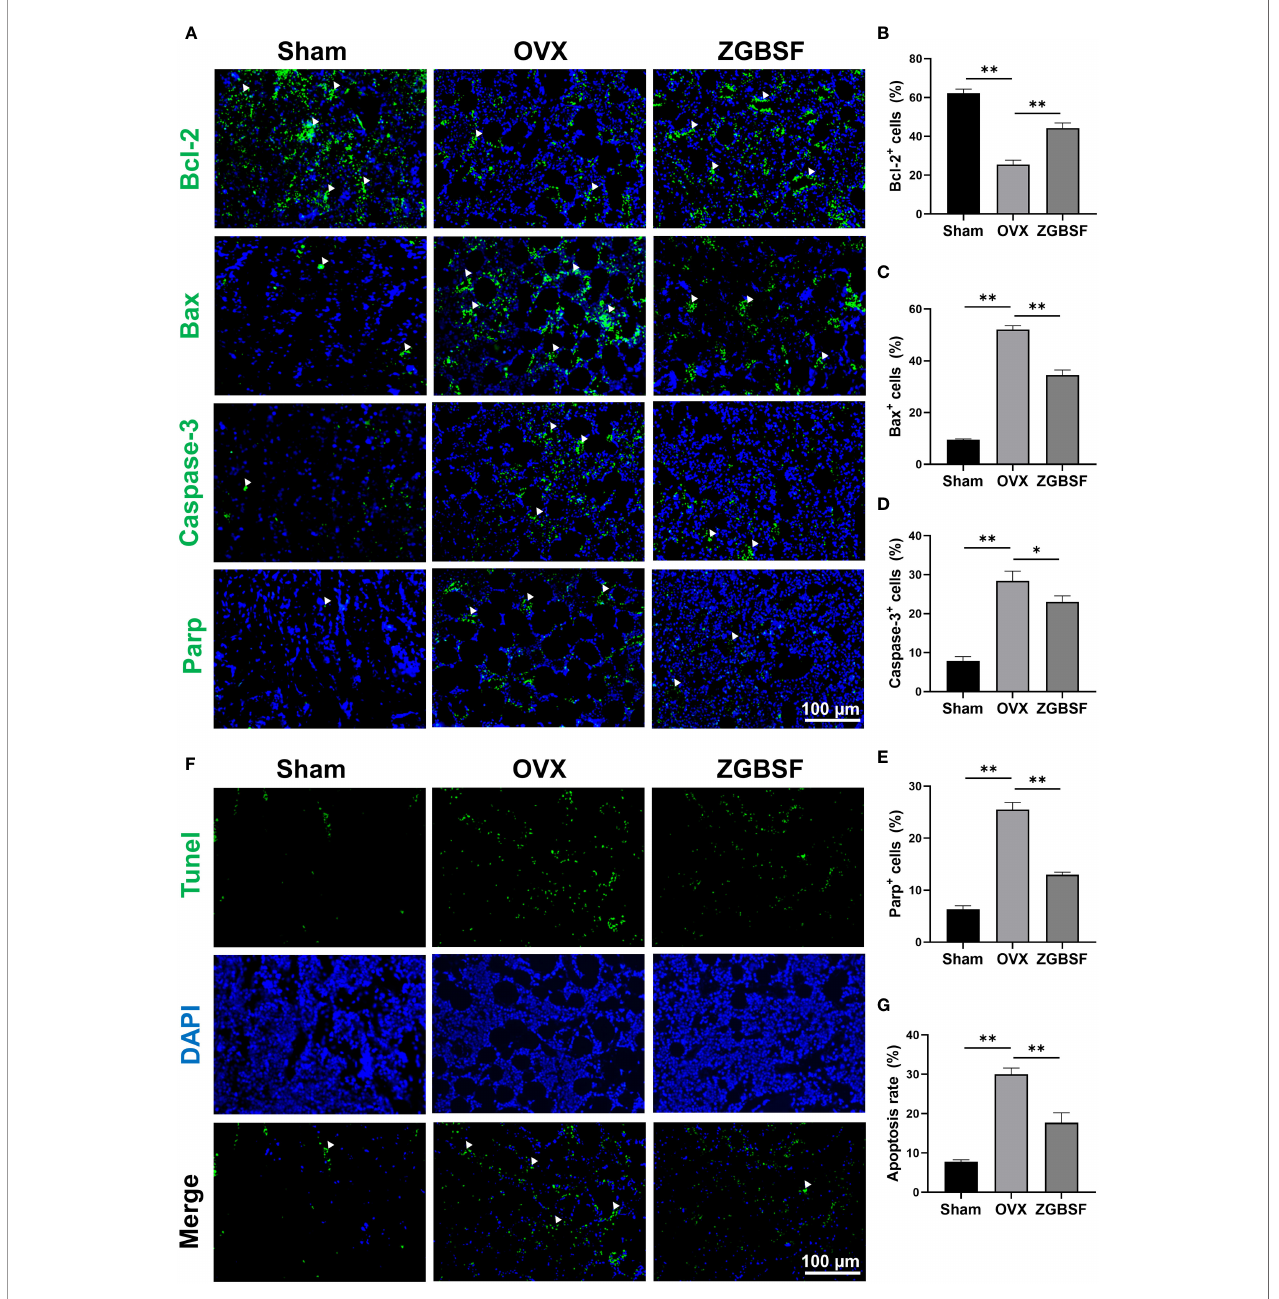
FIGURE 6 | ZGBSF suppresses apoptosis of osteoblasts to ameliorate OP in OVX mice. (A) Immuno fl uorescence of Bcl-2, Bax, Caspase-3 and Parp in distal femur. (B – E) The quanti fi cation of Bcl-2, Bax, Caspase-3 and Parp positive cells. (F) Tunel staining was performed to examine the apoptosis status of osteoblasts. (G) The quanti fi cation of TUNEL positive rates in the distal femur. White arrows indicated the positive expression. Data were presented as mean ± SEM of three independent experiments. * P < 0.05, ** P <